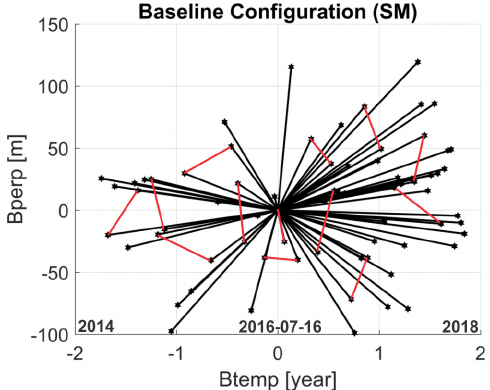
Figure 6. The distribution of both temporal and perpendicular baselines of radar images in the new method. Solid lines represents SM interferogram, and red lines represents the selected SB interferogram for obtaining a-priori defromation